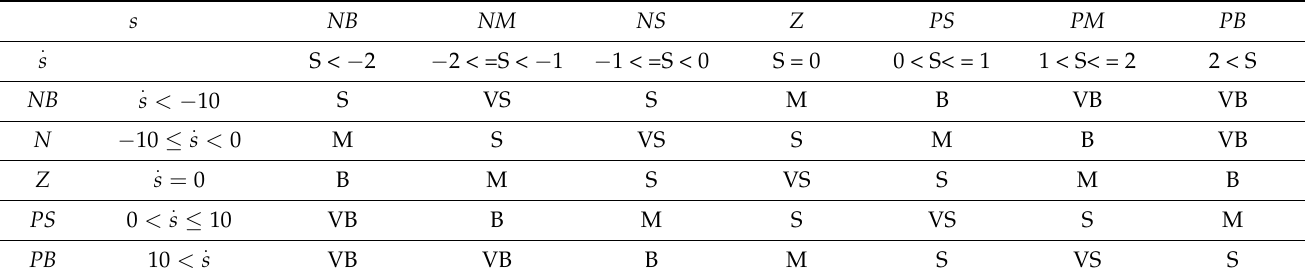
Figure 8. Membership functions: ( a ) member function for input s; ( b ) member function for input 𝑠̇ Table 5. The output fuzzy gain computation.